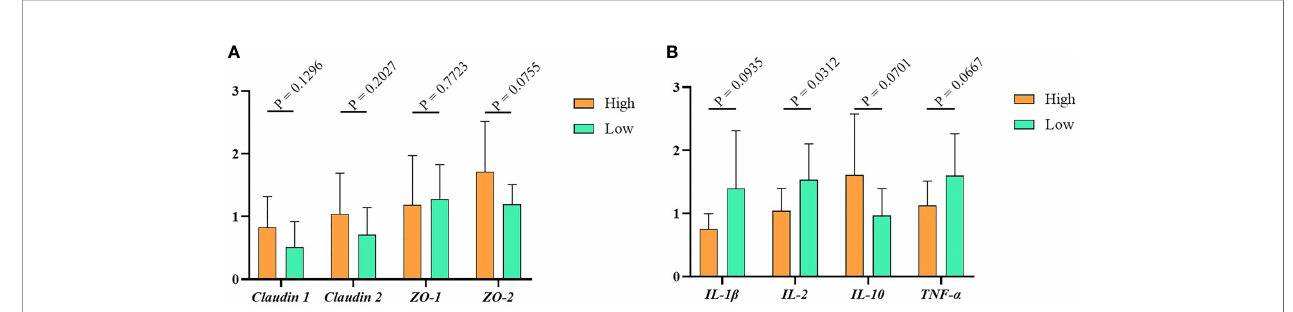
FIGURE 3 | The immunity data of Muscovy Ducks. Two hundred newly hatched ducklings were fed commercial feeds for 70 days before being weighed individually and collected the ileal segment and contents after dissection. The highest 20% and the lowest 20% of the BW-ranked ducks were set as the high and low groups from the 200 Muscovy ducks, respectively. Real-time PCR was used to measure the relative expression of tight junctions (A) and cytokines (B) in the high and low groups with 40 ducks per group. Data were expressed as mean ± SD (n = 40) and analyzed by unpaired two-tailed Students ’ t -test.